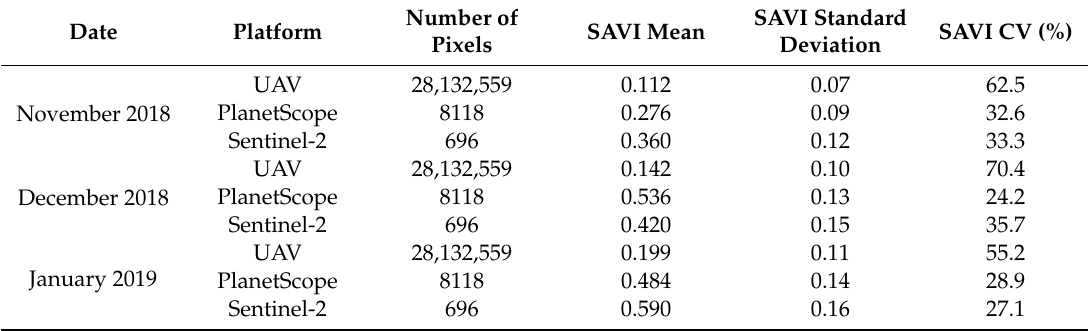
Table 2. Basic statistics considering images of the three platforms (UAV, PlanetScope, and Sentinel-2) at their original